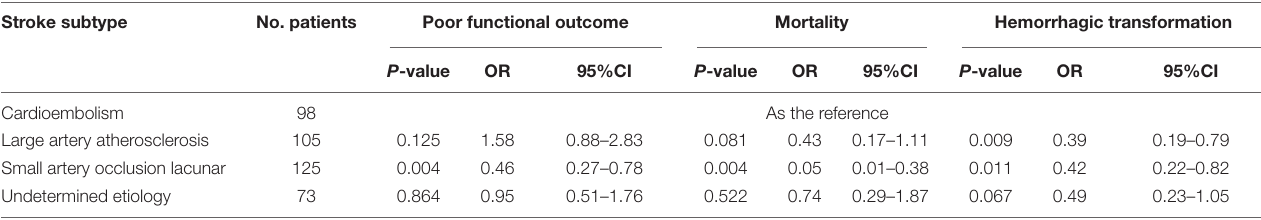
TABLE 3 | Association between stroke subtypes and stroke outcome.